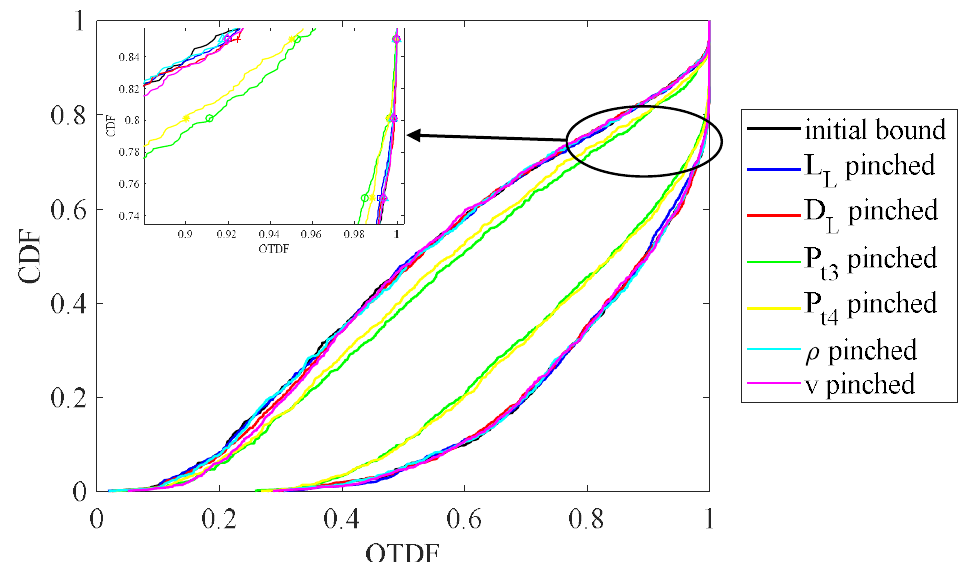
Figure 16. The p−box for OTDF with independent variables after affine transformation.